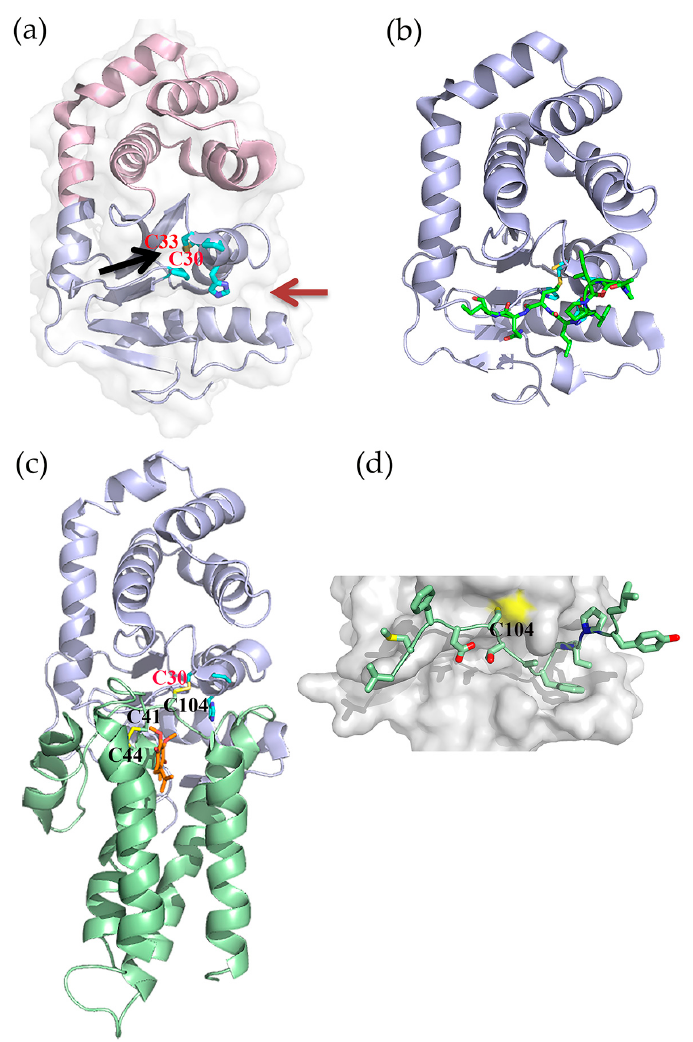
Figure 2. ( a ) Cartoon representation of EcDsbA (PDB 1FVK); thioredoxin fold shown in light blue and helical insert in light pink. Red and black arrows indicate the hydrophobic groove and hydrophobic patch, respectively; ( b ) Substrate peptide binding surface of EcDsbA (PDB 3DKS). Peptide and enzyme are shown in green and light blue respectively; ( c ) Crystal Structure of the EcDsbA–EcDsbB–UQ complex (PDB 2HI7). EcDsbA and EcDsbB are shown in cartoon representation (light blue and green respectively). DsbA Cys30 and DsbB Cys41,44, and 104 are displayed in stick representation. UQ molecule bound to DsbB is displayed in stick representation (orange); ( d ) Close-up view of the DsbB loop interaction site with the hydrophobic groove of EcDsbA. The DsbA the active site residues (Cys30-Pro-His-Cys33) and cis -proline residue are displayed in stick representation (cyan) in panels ( a ) to ( c ).